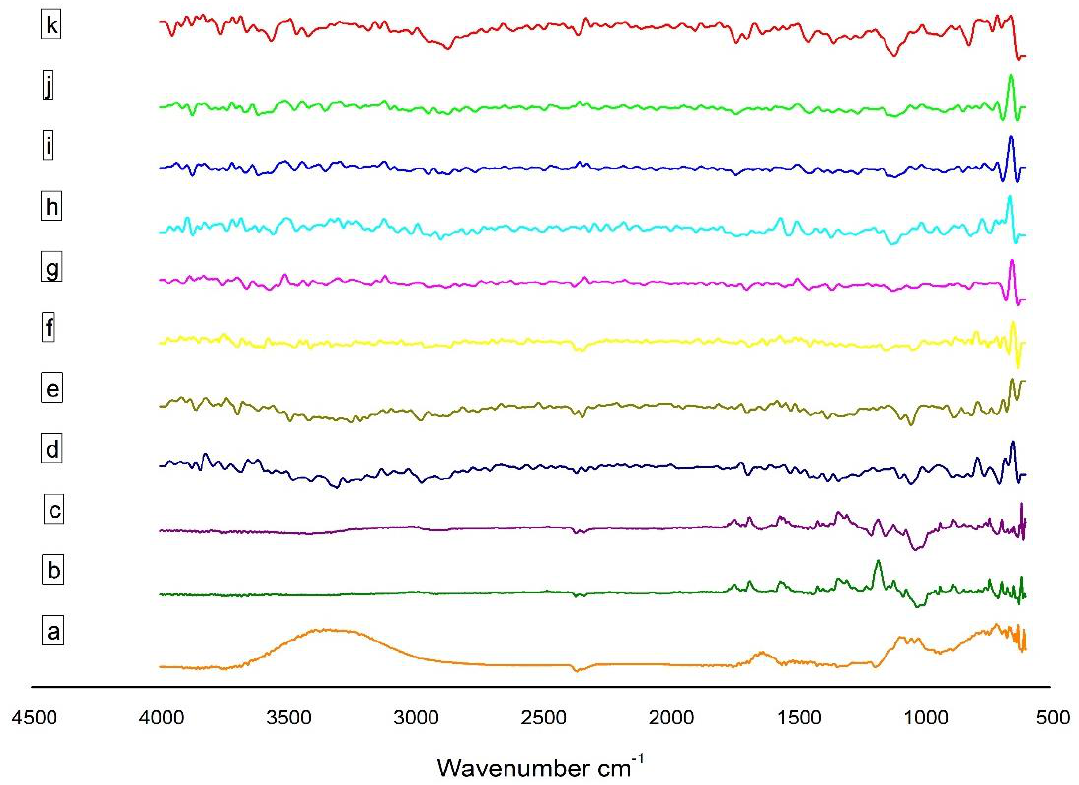
Figure 1. FT-IR of ( a ) EPL, ( b ) β –CD, ( c ) SBE 7 β –CD, ( d ) CS, ( e ) sTPP, ( f ) NP1, ( g ) NP2, ( h ) NP3, ( i ) NP4, ( j ) NP5 and ( k ) NP6.